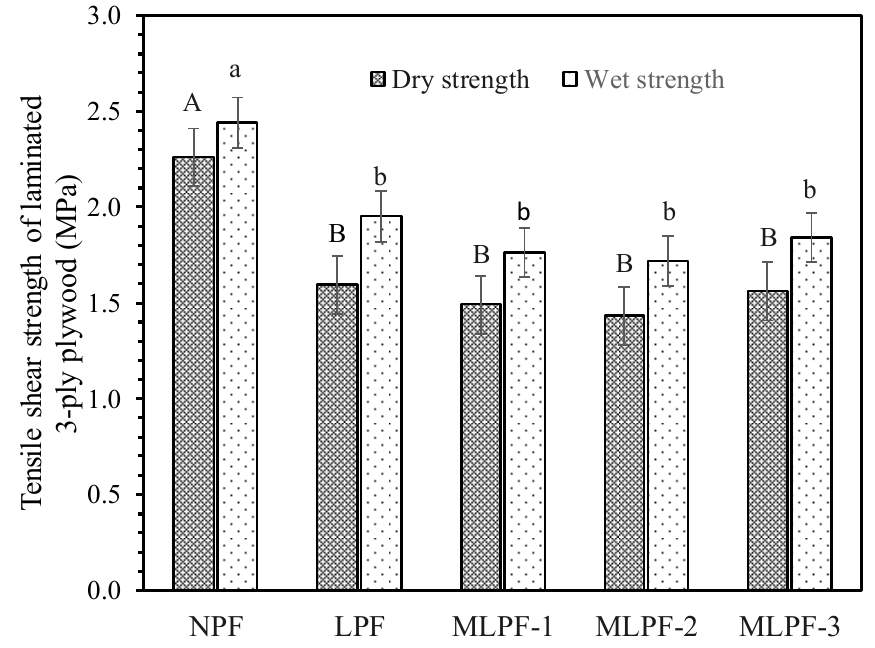
Figure 3. Tensile shear strength of 3-ply plywood bonded with the adhesives.